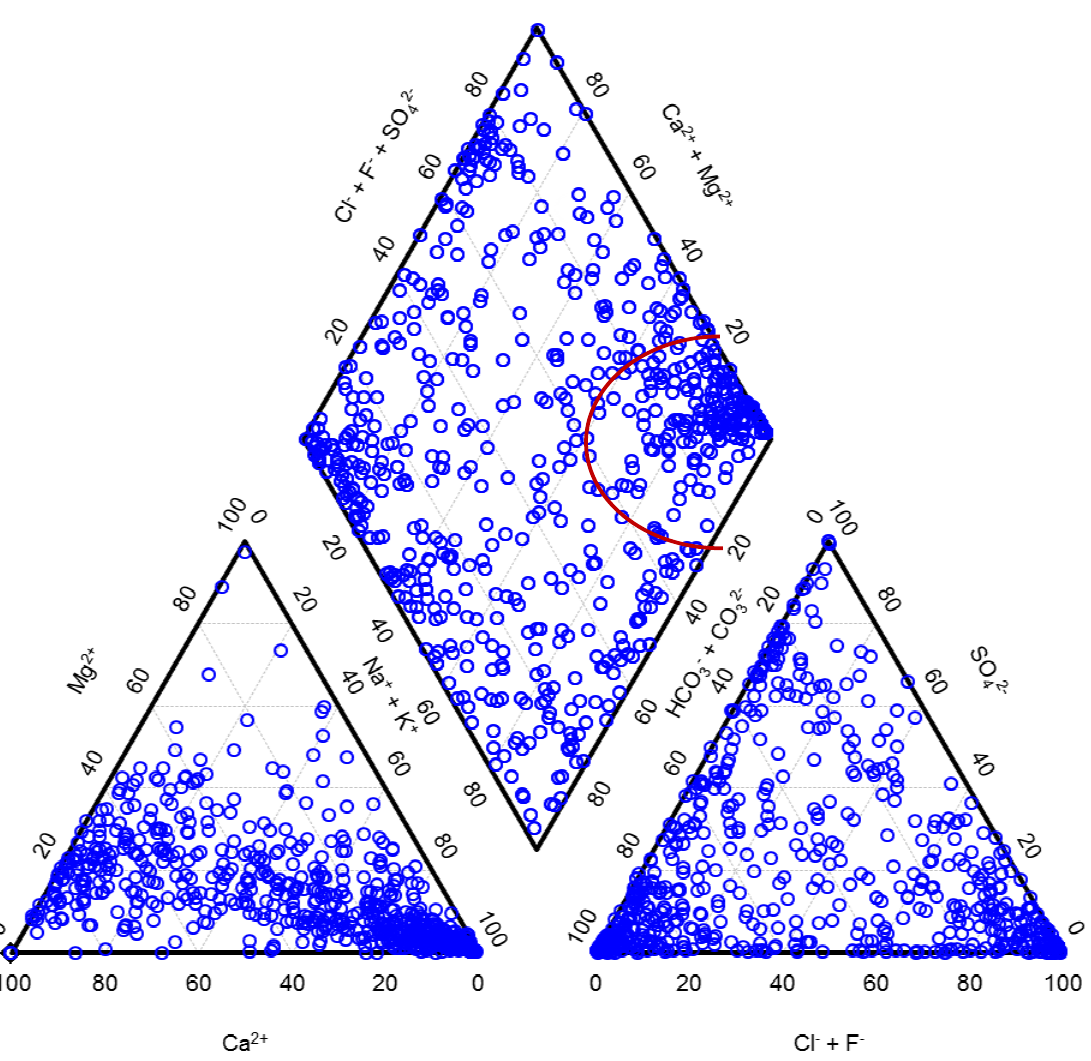
Figure 2. Natural diversity in composition of the Central European mineral and thermal waters. Brines are presented in the right corner of the